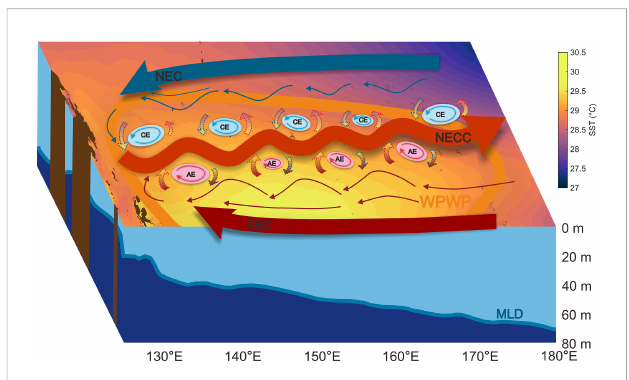
FIGURE 11 Model diagram of short-lived MEs regulating the western Paci fi c warm pool region.